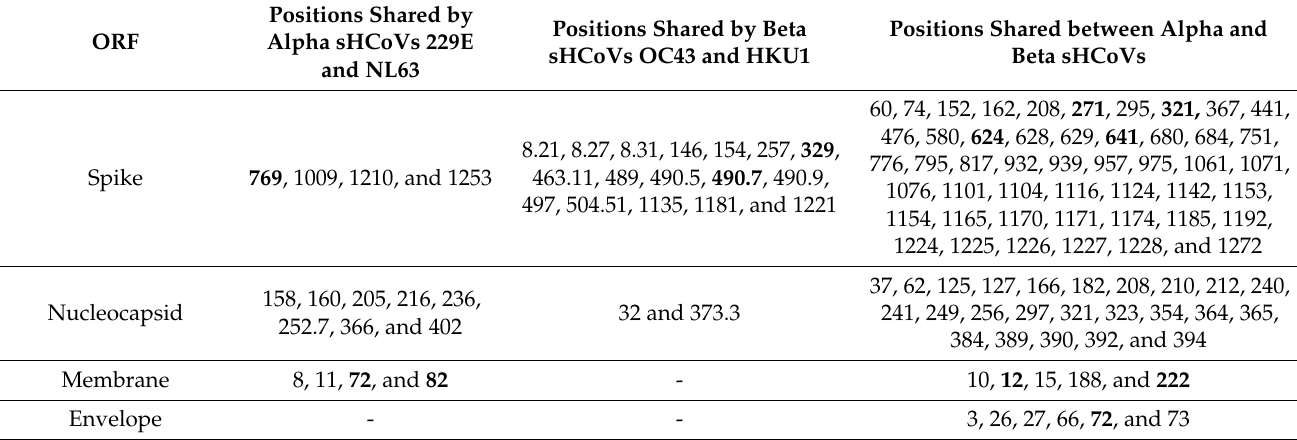
Table 4. A list of positions with AA change in at least two host-jump branches leading to the sHCoVs. Where there was an AA insertion in the sHCoVs relative to the Wuhan-Hu-1 SARS-CoV-2 reference genome, we used the X.Y positional notation where X is the reference genome position and Y is nth sHCoV AA insertion. The positions at which there were no AA changes in branches other than the host-jump branches leading to the sHCoVs are in